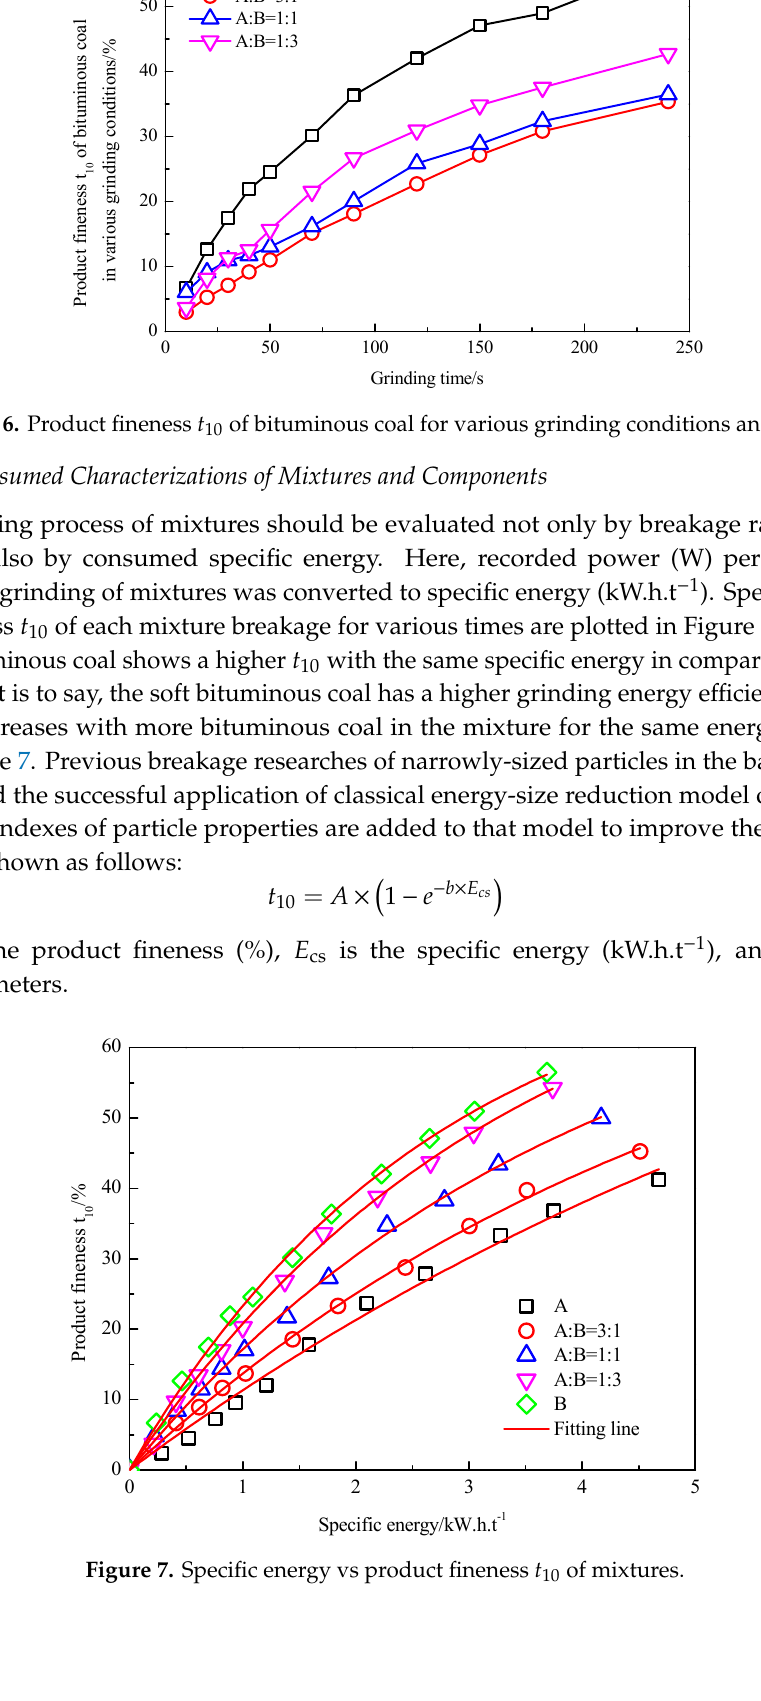
Table 3. Comparison of measured and mass average specific energy. Specific Energy/kW.h.t − 1